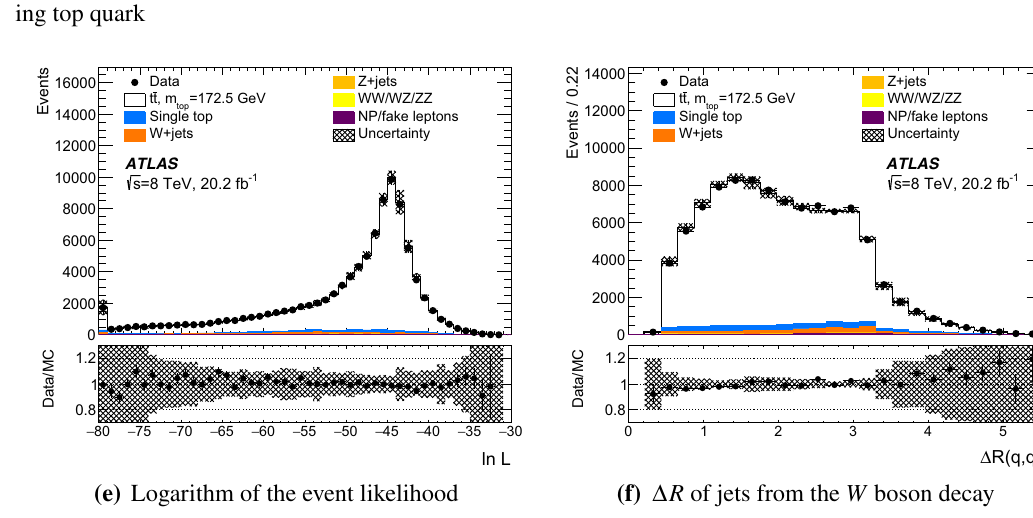
Fig. 1 Distributions for the events passing the preselection. The data are shown together with the signal-plus-background prediction, nor- malized to the number of events observed in the data. The hatched area is the uncertainty in the prediction as described in the text. The right- most bin contains all entries with values above the lower edge of this bin, similarly the leftmost bin contains all entries with values below the upper edge of this bin. a shows the transverse momentum of the lep-